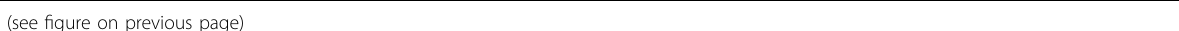
Fig. 6 hUC-MSC-derived CHI3L1 inhibits T cells through PPAR δ /STAT1/3. A GSEA showing that the IL6-JAK-STAT3 pathway is enriched in T cells co-cultured with MSC sh CHI3L1 compared with T + MSC shNTC group. B GSEA showing that the IL6-JAK-STAT3 pathway is repressed in T cells co-cultured with MSC shNTC compared to activated T cells. C – D Heatmap of RNA-sequencing data showing the expression level of genes involved in IL6-JAK- STAT3 pathway in indicated samples. E Western blot for phosphorylated and total STAT1 and STAT3 in T cells with indicated treatments for 2 days. F Western blot for phosphorylated and total STAT1 and STAT3 in T cells cultured with or without rCHI3L1 (100ng/mL). G Heatmap of RNA- sequencing data showing the expression level of PPARD in activated T cells (T cells), T cells co-cultured with MSC shNTC ( + MSC shNTC ), and T cells co-